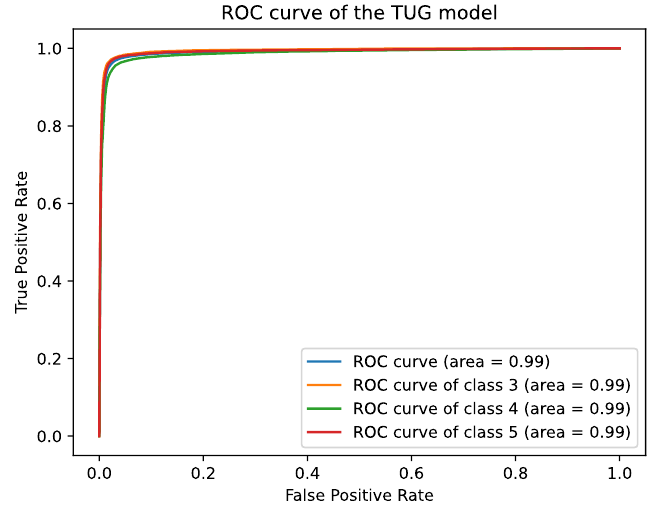
shows an asymptotic behaviour after epoch 25. The best validation accuracy score was 94.29 % at epoch 67.